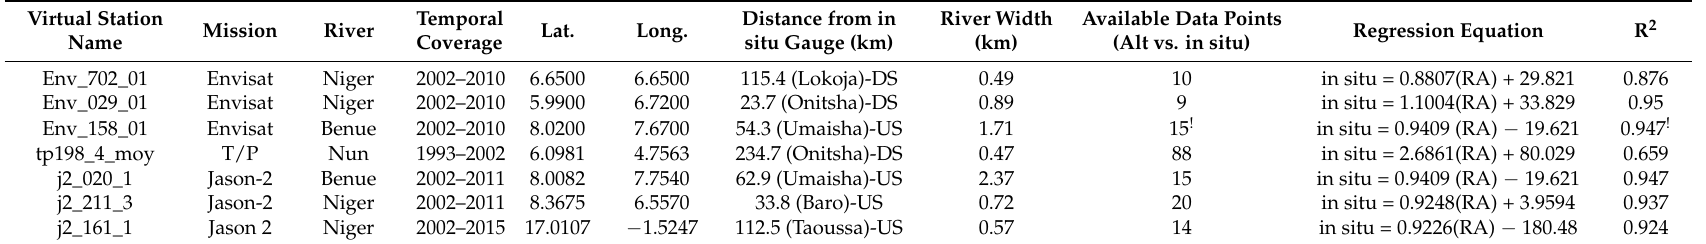
Table 3. Characteristics of the altimetry virtual stations within the study